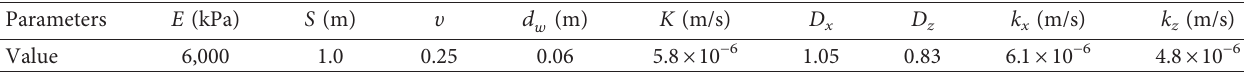
Table 2: Equivalent parameters of drainage plates.